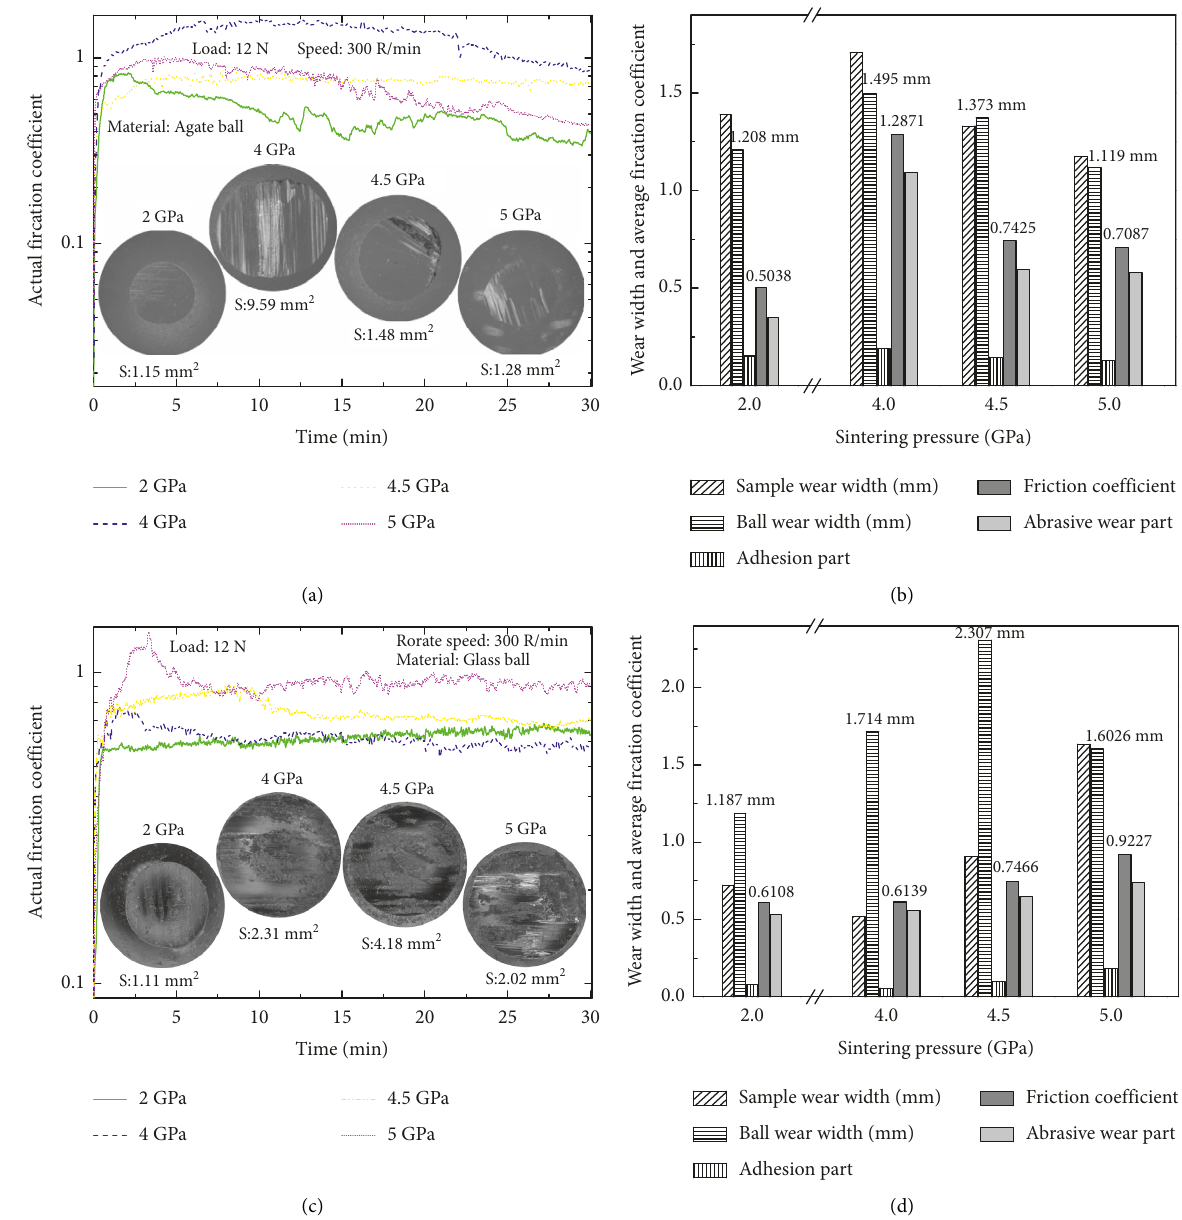
Figure 7: Friction coefficient (a) and wear properties (b) of synthetics and agate pairs; friction coefficient (c) and wear properties (d) of synthetics and glass